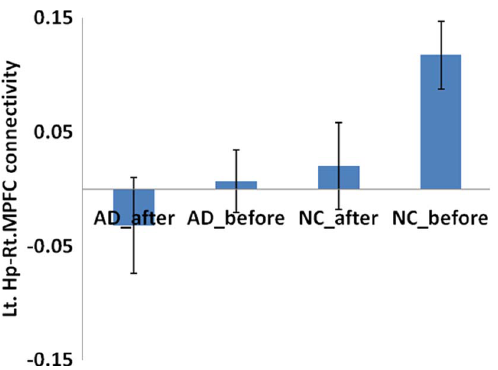
Figure 4. Comparison of connectivity of left hippocampus- right MPFC between pre and post acupuncture among AD patients and controls. There is a significant decreased connectivity following acupuncture for healthy controls (t=1.942, p=0.033). However, the AD patients showed negative connectivity after acupuncture, the different is not significant for the AD patients (t=0.774, p=0.225), doi:10.1371/journal.pone.0091160.g004 When comparing the right hippocampal connectivity between the AD and control groups, there was significantly decreased hippocampal connectivity with the right superior temporal gyrus (STG) and the inferior temporal gyrus (ITG) in the AD group. No regions showed increased connectivity with the right hippocampus in the AD group.